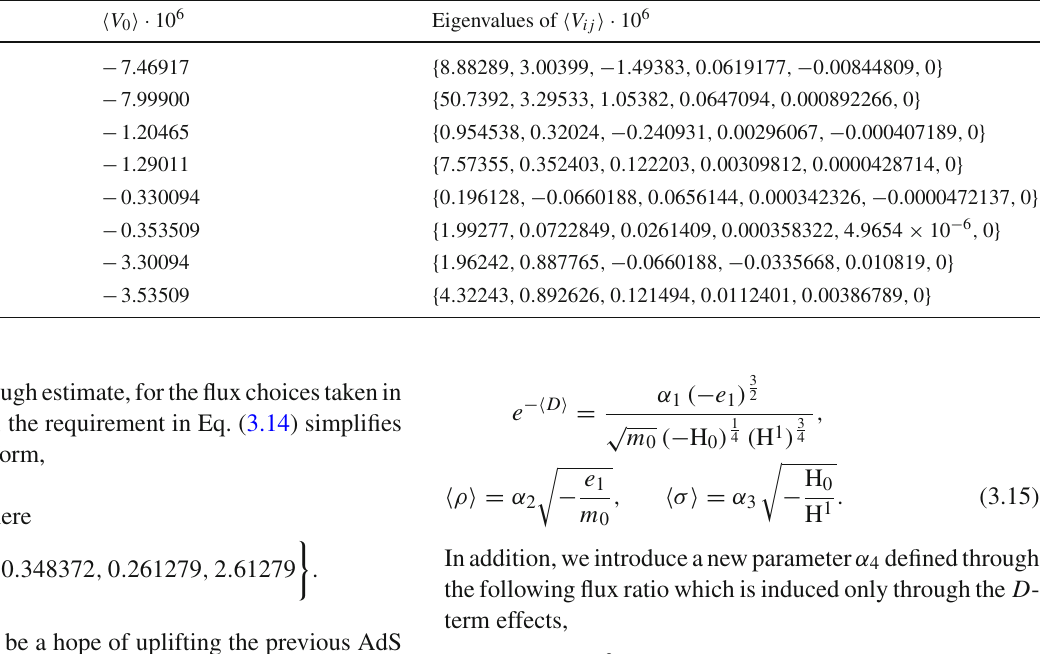
Table 2 Hessian Eigenvalues and the scalar potential VEVs corresponding to the AdS solutions for the flux samplings presented in Table 1. This shows that the first AdS solution is tachyonic while the second AdS solution is tachyon free, but having a flat axionic combination